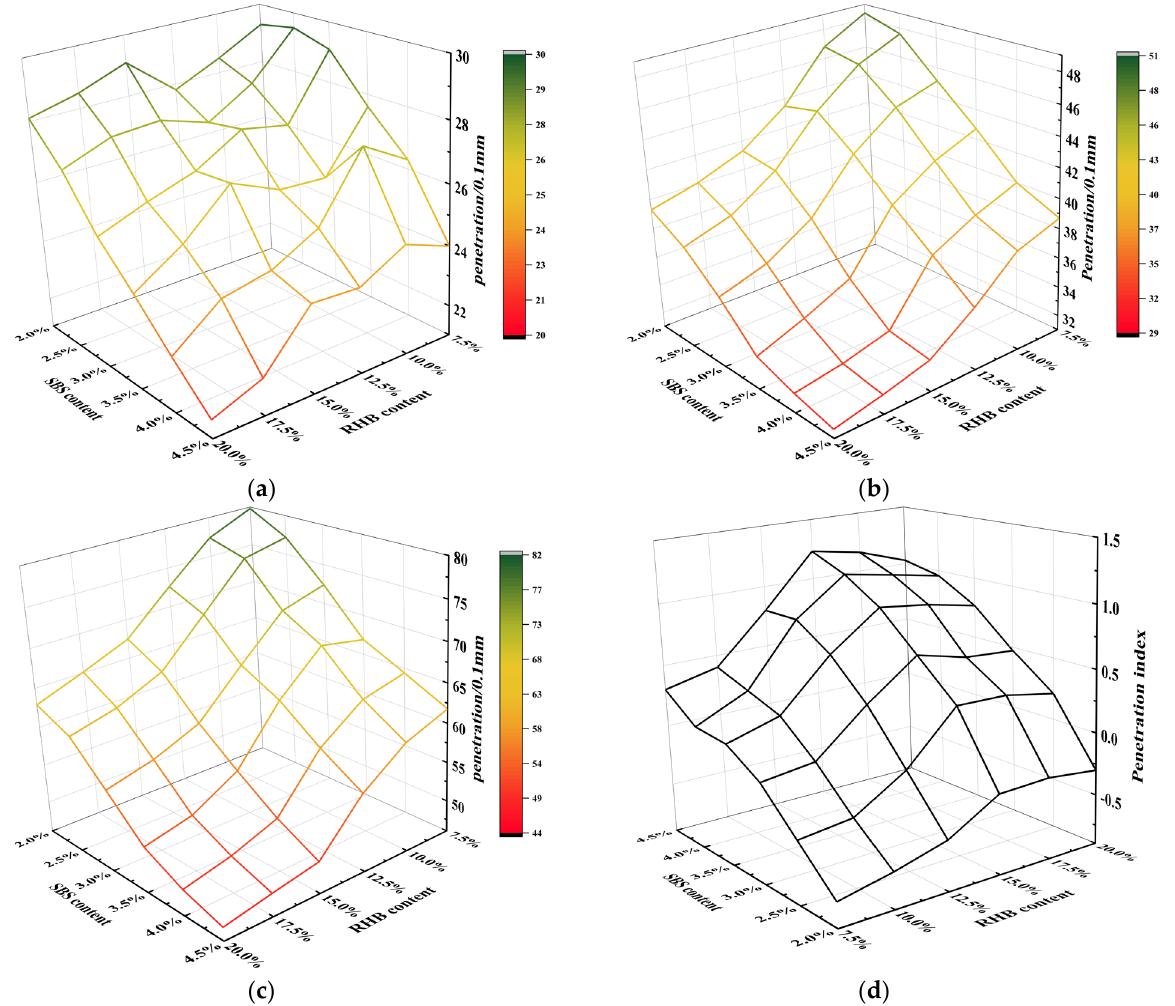
Figure 3. Penetration and penetration index of composite-modified asphalt at different temperatures. ( a ) 15 °C penetration, ( b ) 25 °C penetration, ( c ) 30 °C penetration, ( d ) penetration index.